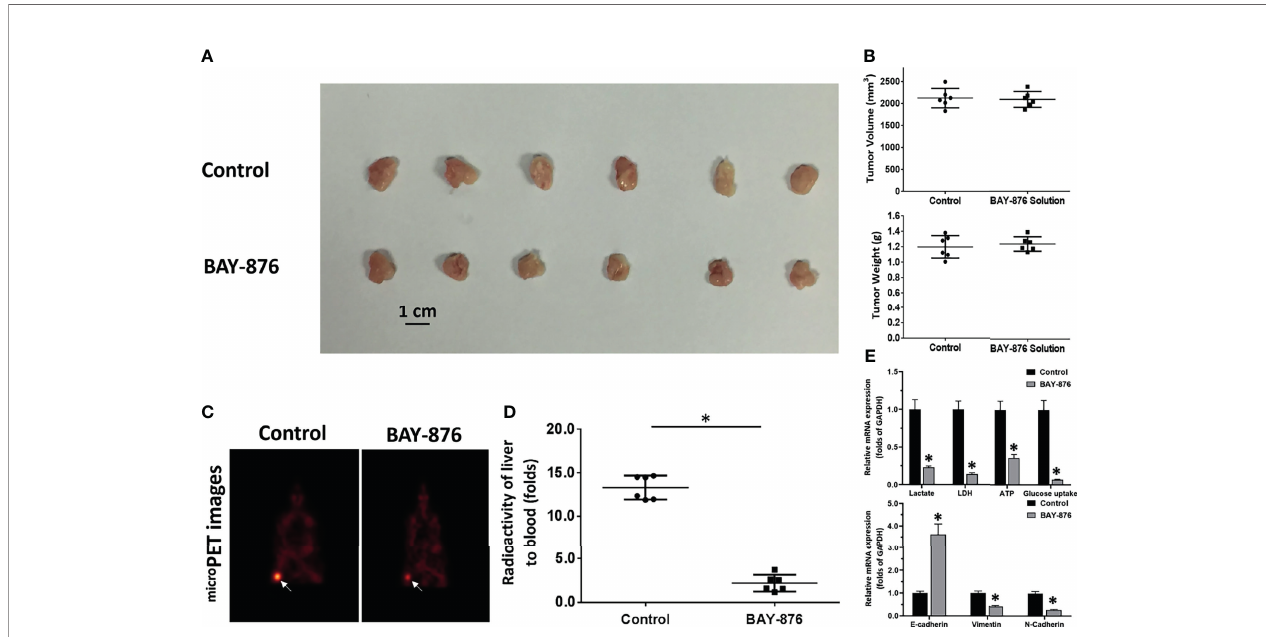
FIGURE 3 | BAY-876 inhibited the Warburg effect of tumor tissues formed by MHCC97-H cells. The MHCC97-H cells were injected into the nude mice to form the subcutaneous tumor models. The mice received oral administration of BAY-876 for three days (once daily). After BAY-876 treatment, the mice were analyzed by microPET. The results are shown as images of subcutaneous tumor tissues (A) , tumor volumes or tumor weights (B) , microPET images (C) , and the quantitative analysis of microPET (the relative nuclide [18F-FDG] intensity [fold change of tumor to blood] by the Geiger counter) (D) , or the Warburg effect. EMT-related factors are shown in (E) . *P<0.05 versus control with